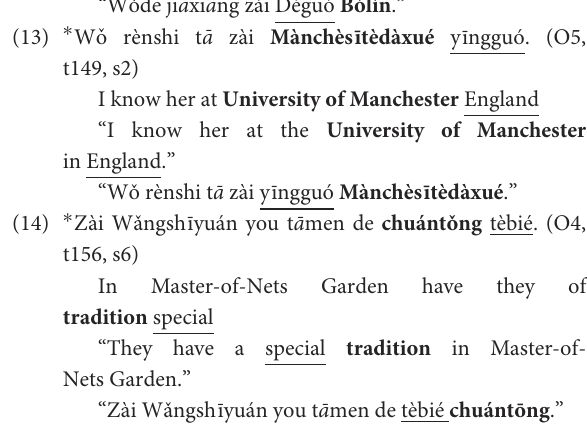
In Master-of-Nets of